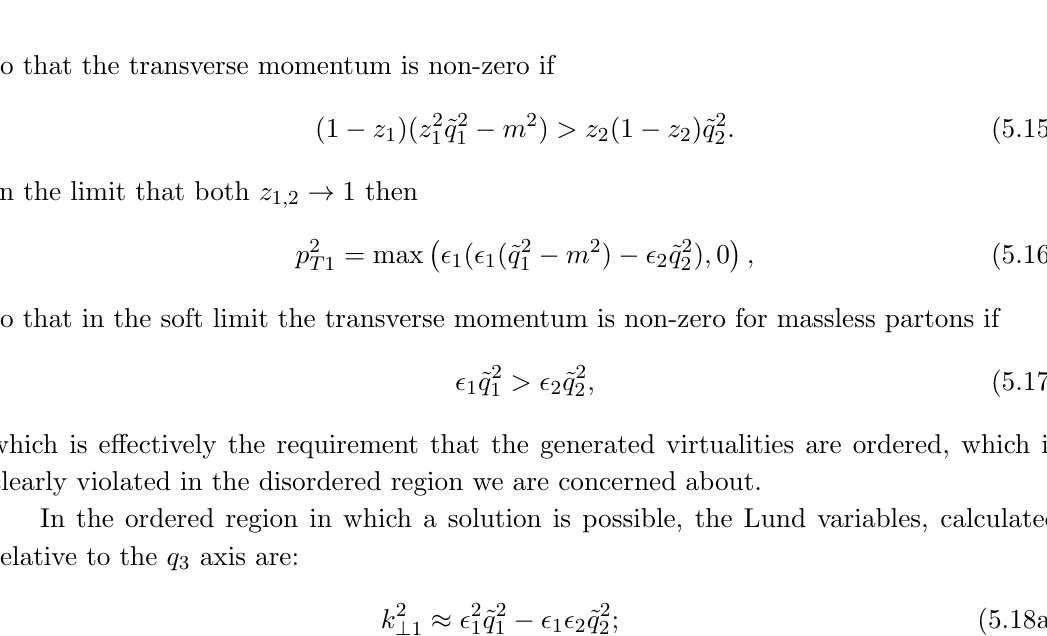
Figure 3 . Region in which the emission angle of the second gluon is smaller than the recoil angle of the quark from the (cid:12)rst-gluon